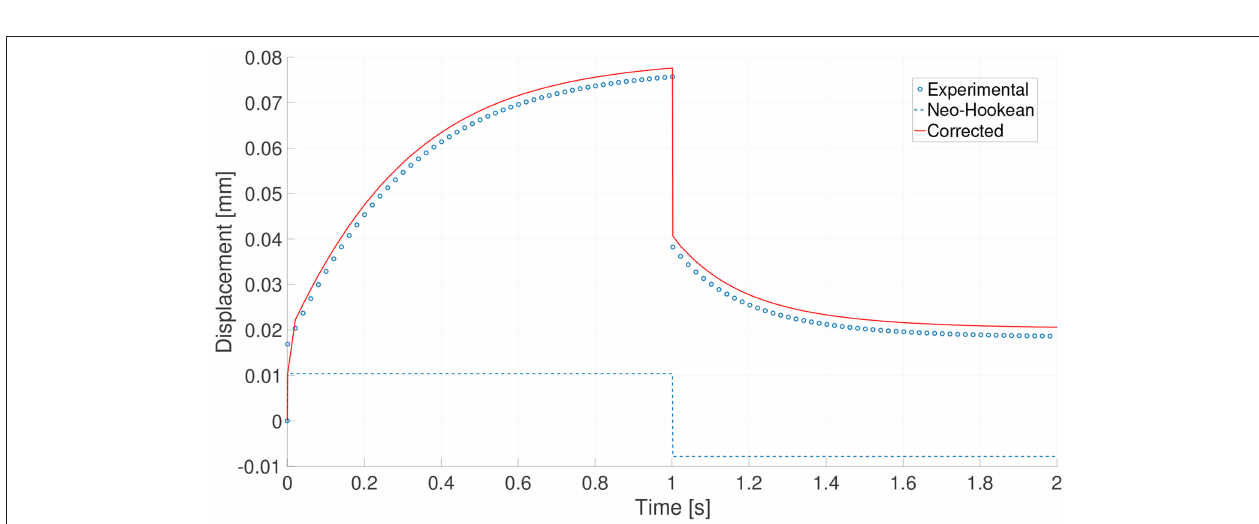
FIGURE 9 | Experimental results (circles) for a new experiment, prediction made by the neo-Hookean model (dashed line) and interpolated corrected model (red line). The interpolation is made by employing the same weights provided by LEE techniques in constructing the constitutive manifold.